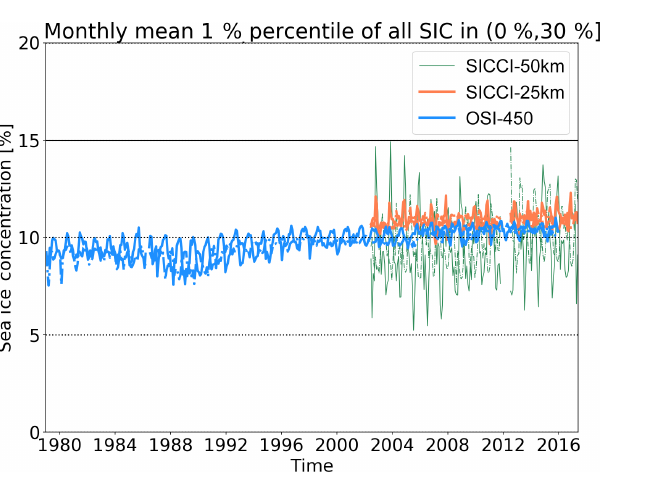
Figure 9. Time series of the monthly mean 1% percentile value of all strictly positive SICs that are below 30% (variable ice_conc) for the three CDRs (blue: OSI-450, red: SICCI-25km, green: SICCI- 50km). Solid lines are for NH; dashed lines are for SH. This time se- ries plot investigates whether the dynamic tuning of the open-water filters results in temporal consistency of the minimum detected true SIC across all